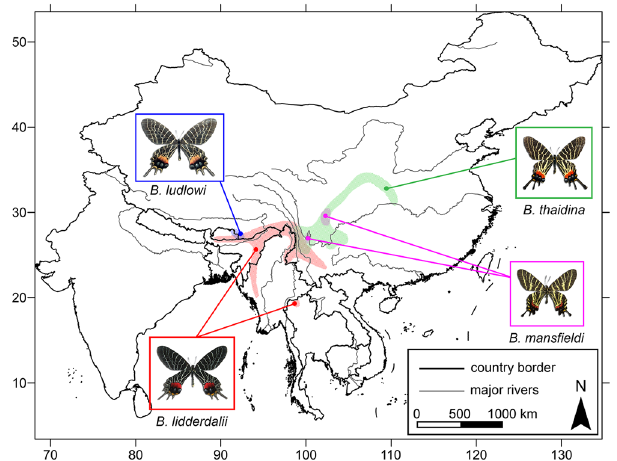
Figure 1. Tentative distribution range of four known species of Bhutanitis swallowtails. Photo of B. ludlowi © The Research Institute of Evolutionary Biology, Tokyo, Japan; photos of B. lidderdalii , B. thaidina , and B. mansfieldi © Shao-Ji